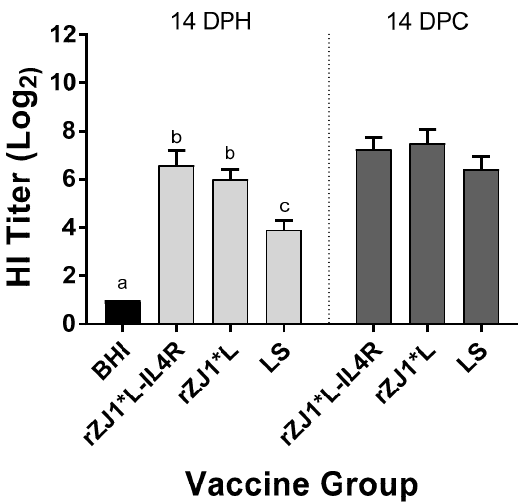
Figure 7. Effect of rZJ1*L-IL4R vaccination at 19 DOE on Pre- and Post-Challenge HI Titers. At 19 DOE, SPF embryonated chicken eggs were vaccinated in ovo with 10 3.5 EID 50 /egg of rZJ1*L-IL4R, rZJ1*L, LS, or with brain heart infusion (BHI). Serum was collected at 14 DPH, prior to challenge, and at 14 DPC (28 DPH). Birds were challenged with 10 5 EID 50 /bird of vZJ1. Group means were analyzed using One-way ANOVA followed by a multiple comparisons Tukey’s test, with a level of significance of p ≤ 0.05. Significant differences are denoted by different letters.